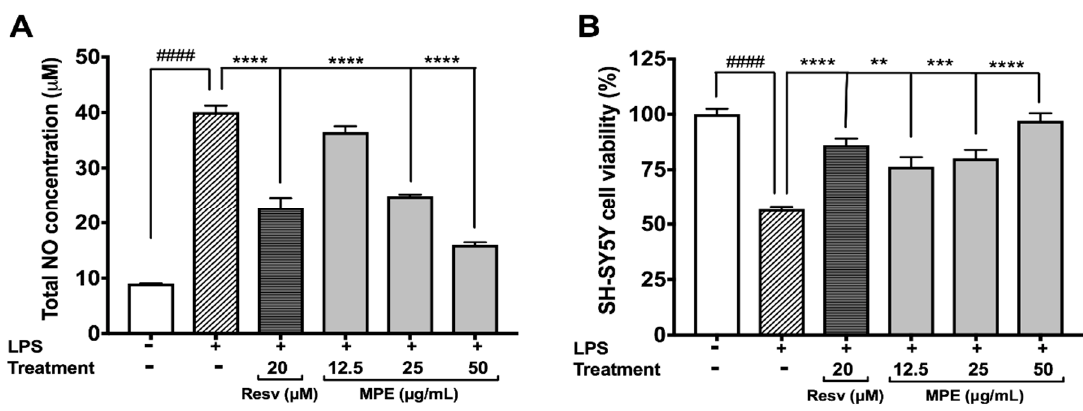
Figure 2. Effects of MPE (12.5, 25, 50 μ g/mL) on production of nitric oxide in BV-2 microglia and resulting influence in non-contact co-culture in SH-SY5Y neuroblastoma. Effects on levels of nitric oxide produced in BV-2 induced with lipopolysaccharide (LPS) ( A ), and on SH-SY5Y cell viability after co-culture with BV-2 LPS-induced media ( B ). All data expressed as mean ± standard error ( n = 3), significance was reported by ANOVA followed with Dunnett multiple comparison testing, as compared with control p ≤ 0.0001 (####); as compared with toxic agent, p ≤ 0.01 (**), p ≤ 0.001 (***), and p ≤ 0.0001 (****).